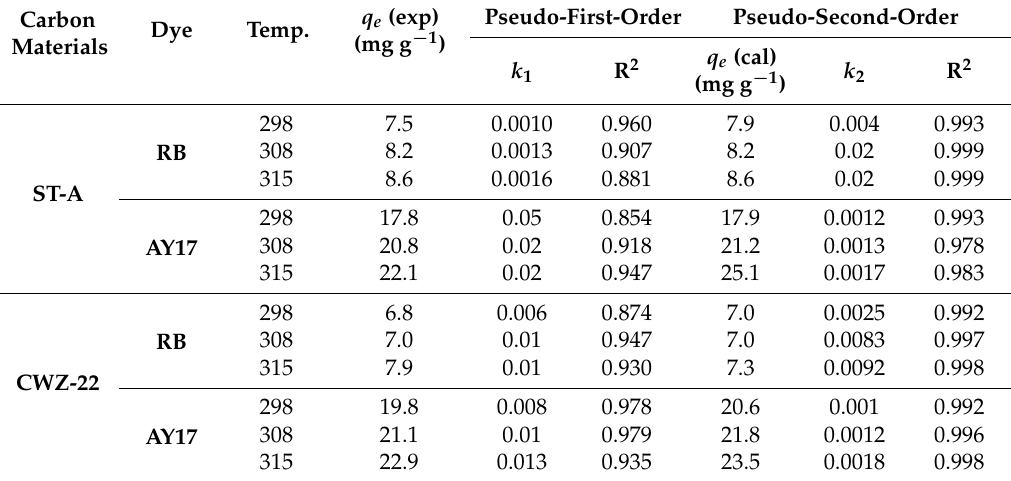
Table 6. Kinetic parameters of RB and AY17 adsorption on the carbon